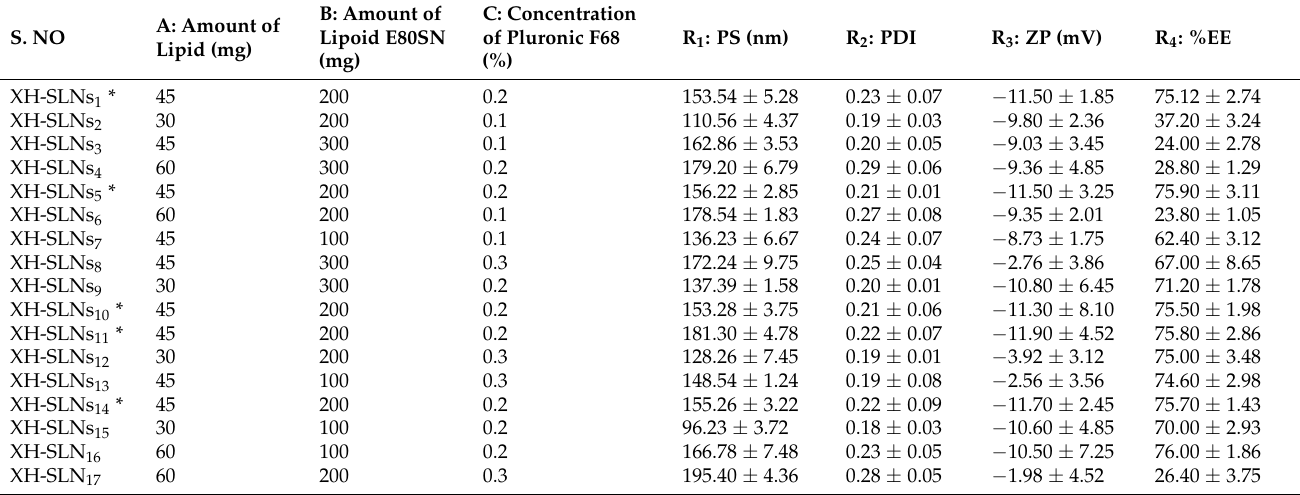
Table 5. BBD table indicating experimental observed